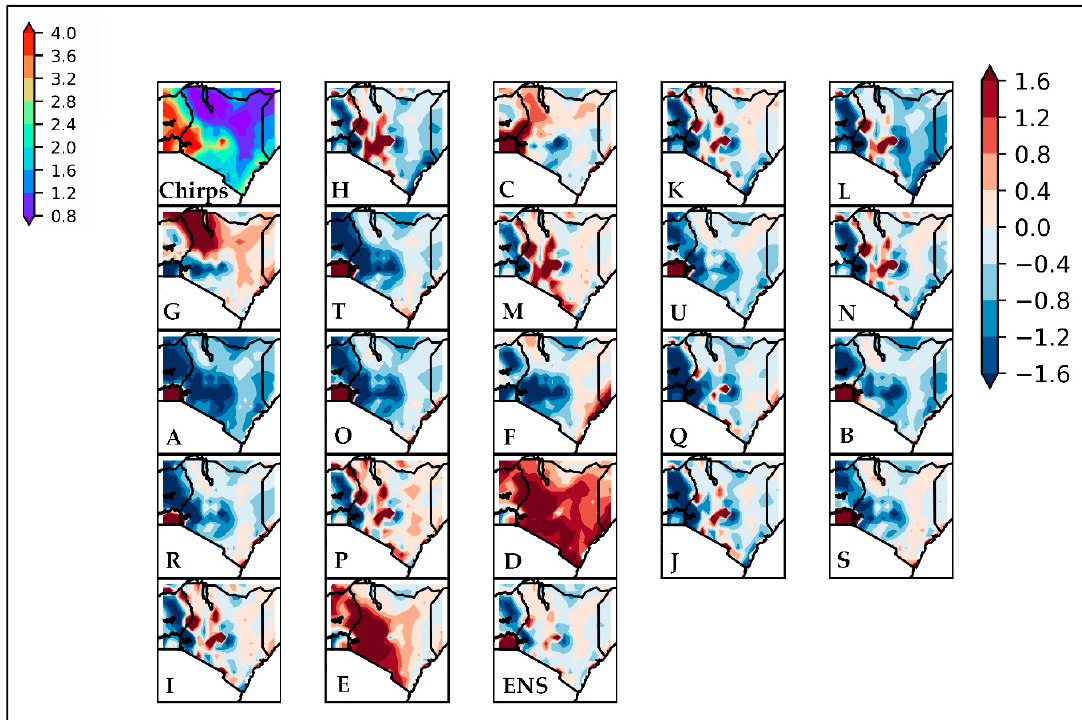
Figure 8 . Bias plot of the observation against individual model: [The letters A to U represent the models’ IDs referred in Table 2) .